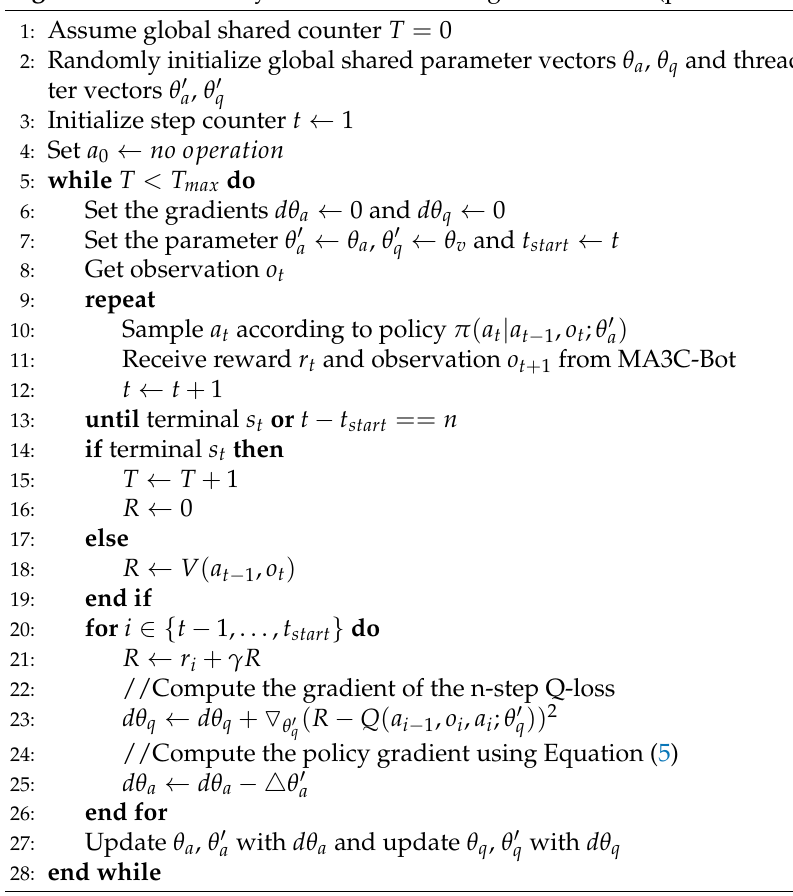
Algorithm 1. Mean Asynchronous Advantage Actor-Critic (pseudo code for each